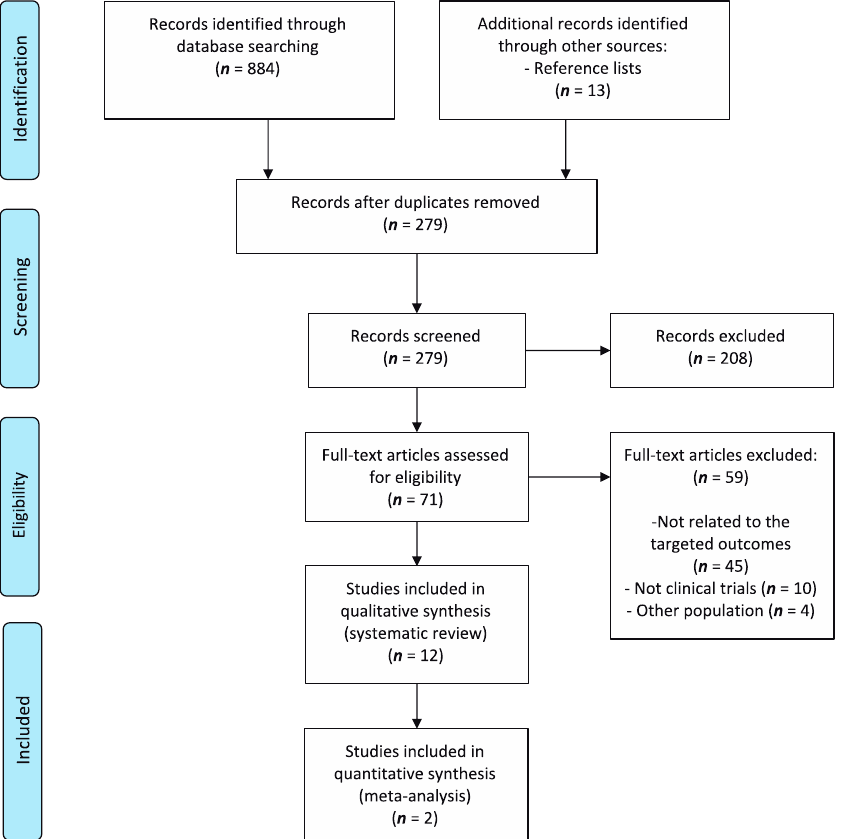
Figure 1. Information flow diagram of the selection process of the systematic review and meta-analysis.